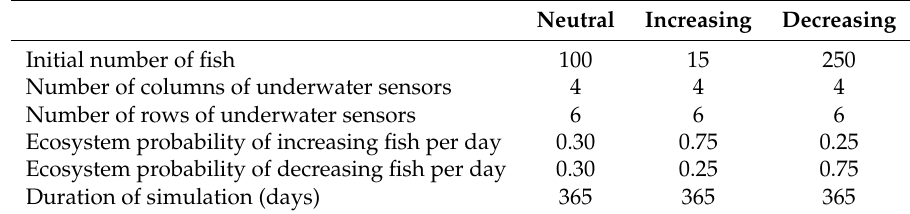
Table 1. Input parameters of the simulator for the different ecosystem types. Neutral Increasing